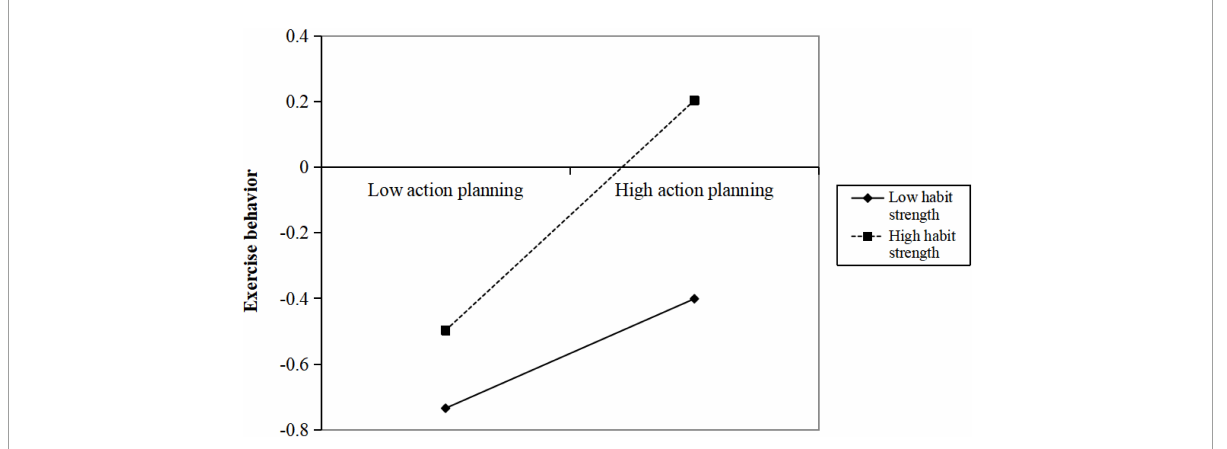
FIGURE2 Habit strength moderated the relationship between action planning and exercise behavior. Low: 1 standard deviation below the mean; High: 1 standard deviation above the mean.